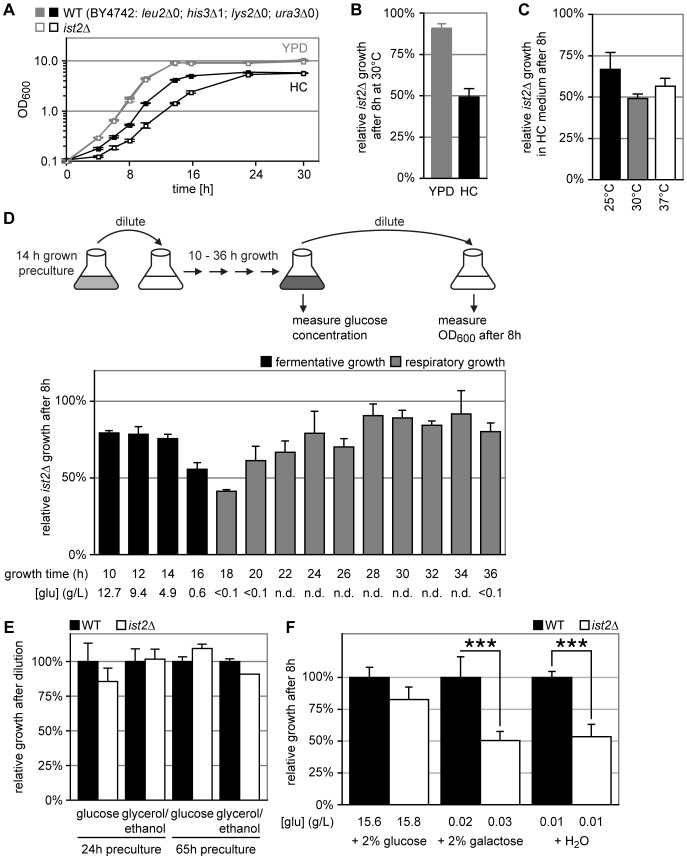
Transition from fermentation to respiration is impaired in ist2Δ.(A) WT (BY4742 = leu2Δ0, his3Δ1, lys2Δ0, ura3Δ0; closed squares) and ist2Δ (open squares) cells were grown in YPD (grey) or HC (black) media at 30°C. Cells were diluted to 0.1 OD600 from pre-cultures grown in HC for 24 hours at 25°C. (B) Growth of ist2Δ cells relative to WT ( = 100%) 8 h after dilution into YPD (grey) and HC (black) media. (C) Growth of ist2Δ cells relative to WT ( = 100%) at 25°C (black), 30°C (grey) or 37°C (white) 8 h after dilution into HC medium. (D) WT and ist2Δ cells were pre-cultured for 14 hours in HC medium to 2.60±0.94 and 3.50±0.94 OD600, respectively and inoculated to 0.1 OD600 into fresh HC medium. At the indicated time points the glucose concentration (g/L) of the medium was determined. Additionally, cells were diluted to 0.1 OD600 into fresh HC medium, grown for 8 hours and relative growth of ist2Δ cells was determined (see cartoon for overview; pc: pre-culture). Growth phase was classified as respiratory (grey) when media glucose concentration was <0.1 g/L. Error bars indicate s.d.m., n = 3. (E) WT (black) and ist2Δ (white) cells were grown in HC media containing 3% glycerol and 2% ethanol as sole carbon source for 24 hours to 2.4±0.7 and 2.4±0.7 OD600 or for 65 hours to 10.9±0.7 and 11.2±0.3 OD600, respectively. Cells were diluted to 0.1 OD600 into fresh HC media containing 2% glucose or 3% glycerol and 2% ethanol and grown for 8 hours. OD600 was normalized to the respective WT and is shown as mean+s.d.m. (n = 6 for 24 hours pre-cultures and n = 3 for 65 hours pre-cultures). (F) WT and ist2Δ cells were grown in HC medium with 2% glucose for 18 hours until glucose depletion. Cultures were supplemented with 2% glucose, 2% galactose or mock treated with water for 30 min and diluted to 0.1 OD600 into HC medium containing 2% glucose and grown for 8 hours. OD600 was normalized to the respective WT. Error bars indicate s.d.m (n ≥5). The glucose concentration was measured after 30 min of treatment. Triple asterisks indicate significance of p<0.001 (unpaired, two-tailed student’s t-test).